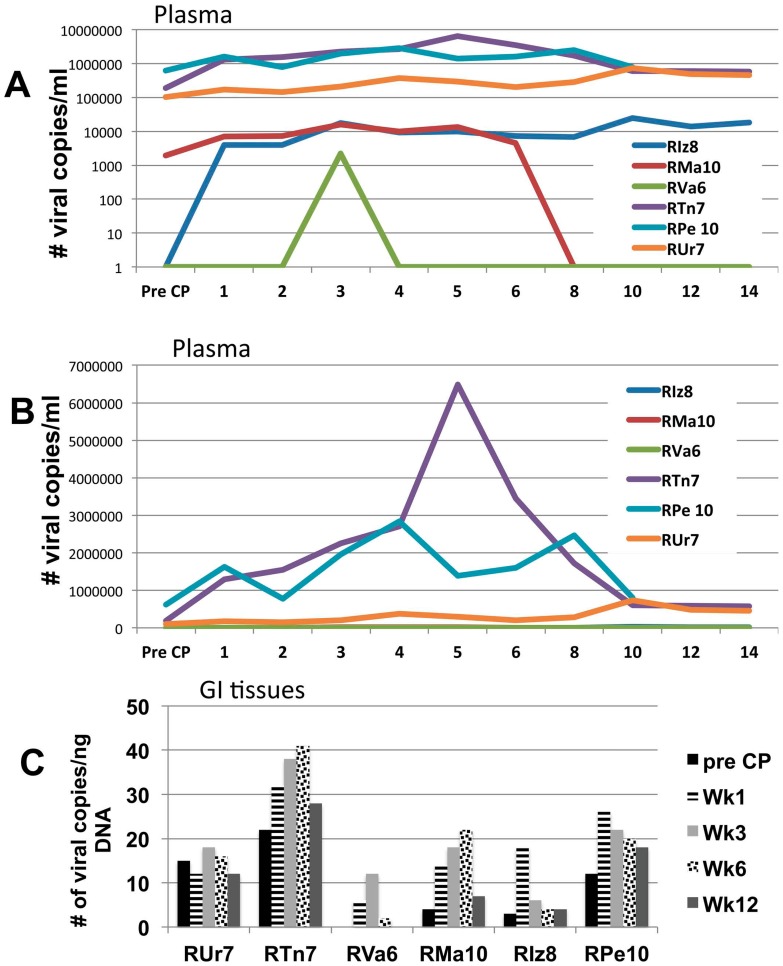
Effect of JAK3 inhibitor on plasma and gastro-intestinal tissue viral loads.Aliquots of the plasma samples obtained prior to and post administration of the JAK3 inhibitor from each of the 6 monkeys were assayed for levels of SIV (commercially performed). A) Reflects # of viral copies/ml of plasma obtained from each of the 6 monkeys at weekly intervals until week 6, bi-weekly until week 14 is illustrated using a log scale to highlight differences seen in monkeys with low viral loads B) Reflects # of viral copies/ml of plasma obtained from each of the 6 monkeys at weekly intervals until week 6, bi-weekly until week 14 is illustrated using an arithmetic scale to highlight differences seen in monkeys with high viral loads C) Reflects the viral copies/ng DNA isolated from a pool of colo-rectal biopsies from each of the 6 monkeys obtained prior to (baseline) and at weeks 1, 3, 6 and 12 post JAK3 inhibitor administration.